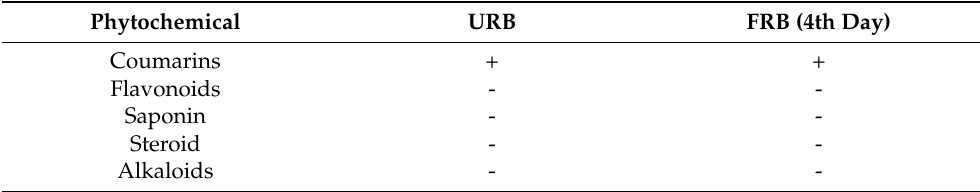
Table 1. Chemical composition of unfermented rice bran (URB) and fermented rice bran (FRB) (4th day)